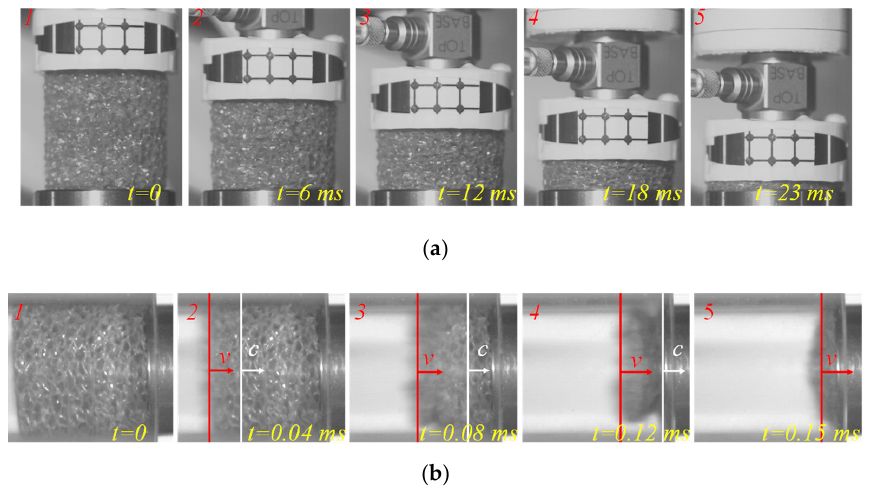
Figure 10. The typical deformation progress of the foam in drop weight impact test and shock tube test: ( a ) drop weight impact test; ( b ) shock tube experiment. Here, v represents the velocity of the compression deformation, and c represents the impact velocity in the foam.